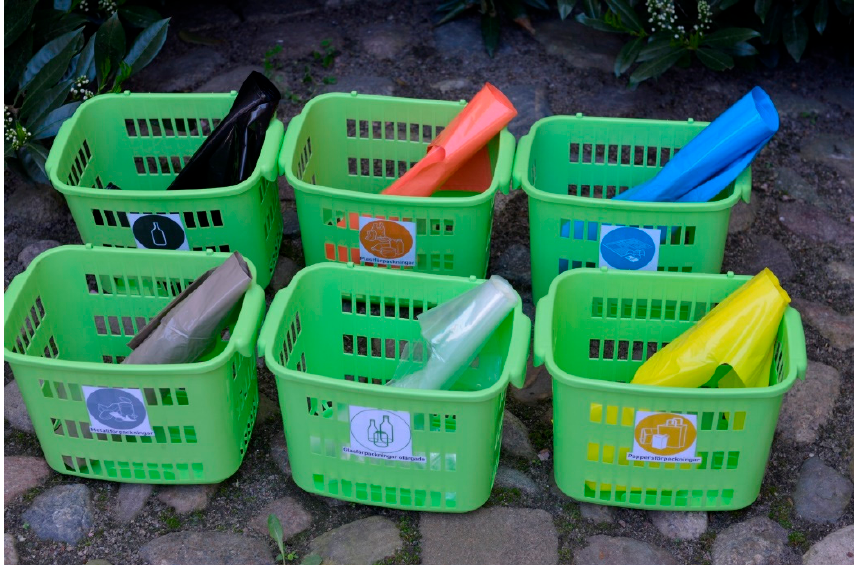
Figure 3. Waste baskets and coloured bags labelled with the type of waste that should go into each bag that was used in the project. Food waste (green bags) and residual waste (other bags) was already collected from the properties prior to the